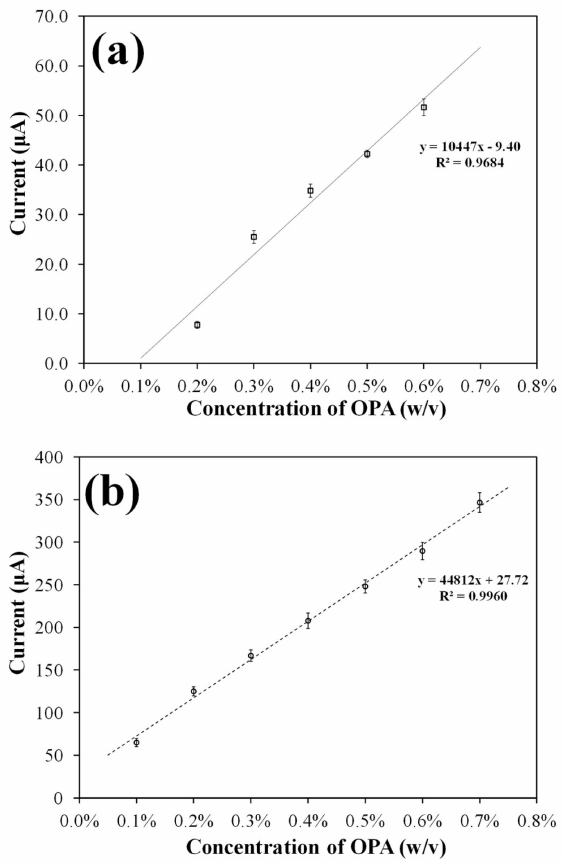
Figure 8. Calibration curve comparison between the OPA sensor and amperometry with SPCEs. ( a ) the PA hydrogel-modified SPCE strips were conditioned by exposing them to 5 µ L of OPA for 20 s before applying +0.8 V vs. Ag/AgCl. The sensitivity was found to be about 3.3 µ A/cm 2 mM, and the variation coefficient was less than 10% (n = 3). ( b ) OPA detection was carried out using bare SPEC strips in batch (0.1 M PBS, pH 7.6) containing 50 mM glycine and 30 mM NAC. The electrodes were subjected to the same potential as in condition ( a ), and the sensitivity was about 14.2 µ A/cm 2 mM, with the variation coefficient being less than 3% (n =